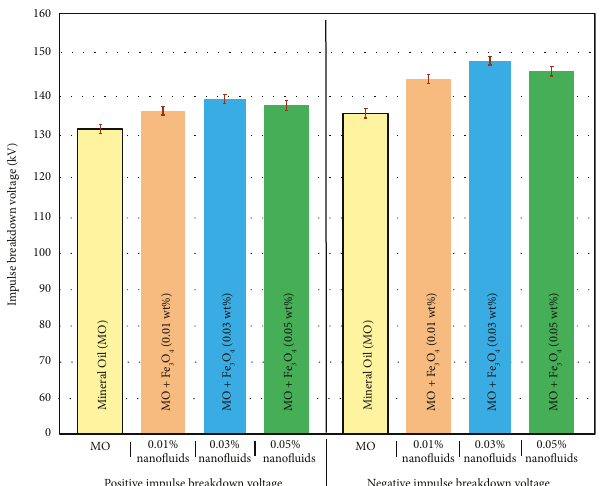
Figure 10: Average values of lightning impulse breakdown voltage strengths of pressboard impregnated with nanofluids-based min- eral